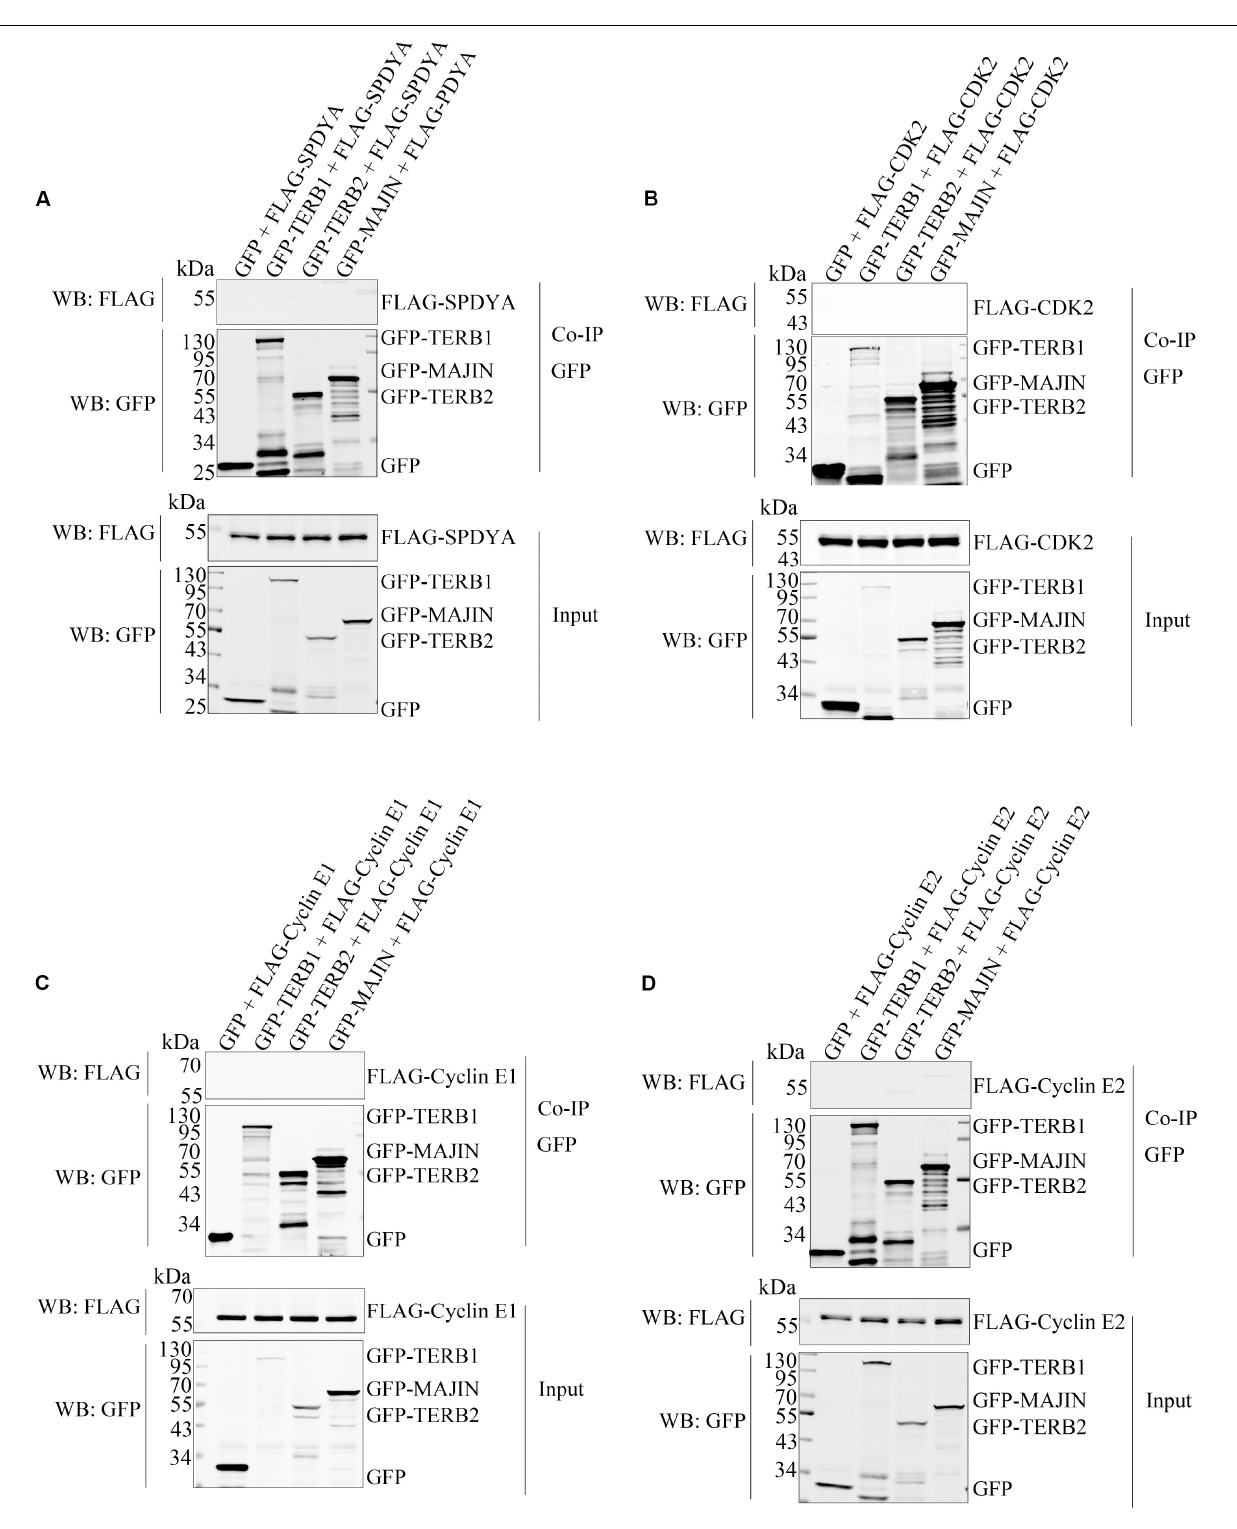
Frontiers in Cell and Developmental Biology |